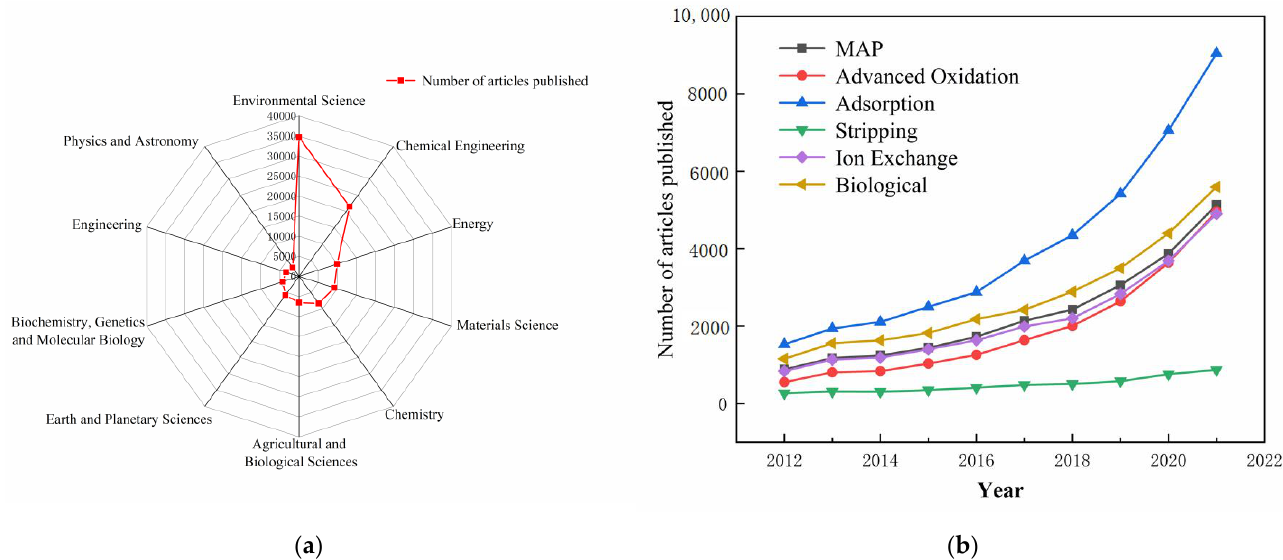
Figure 1. Literature survey on wastewater denitrification from 2012 to 2021: ( a ) fields of the relevant publications and ( b ) the degree of attention given to various denitrification methods used.